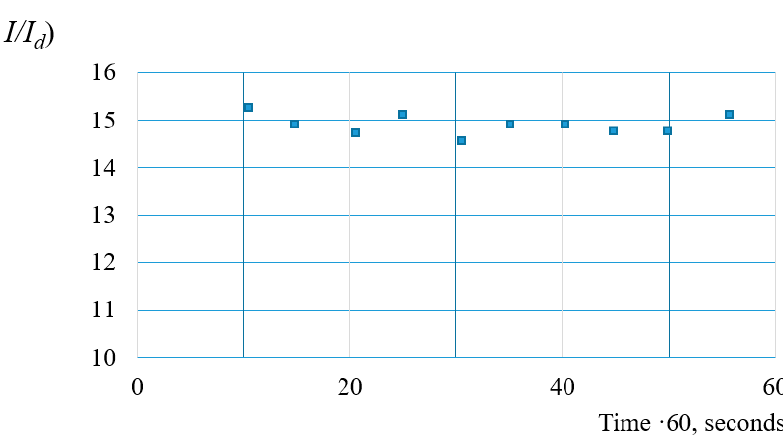
Figure 7. Increase in mass transfer intensity between propane and water compared to free diffusion mode.